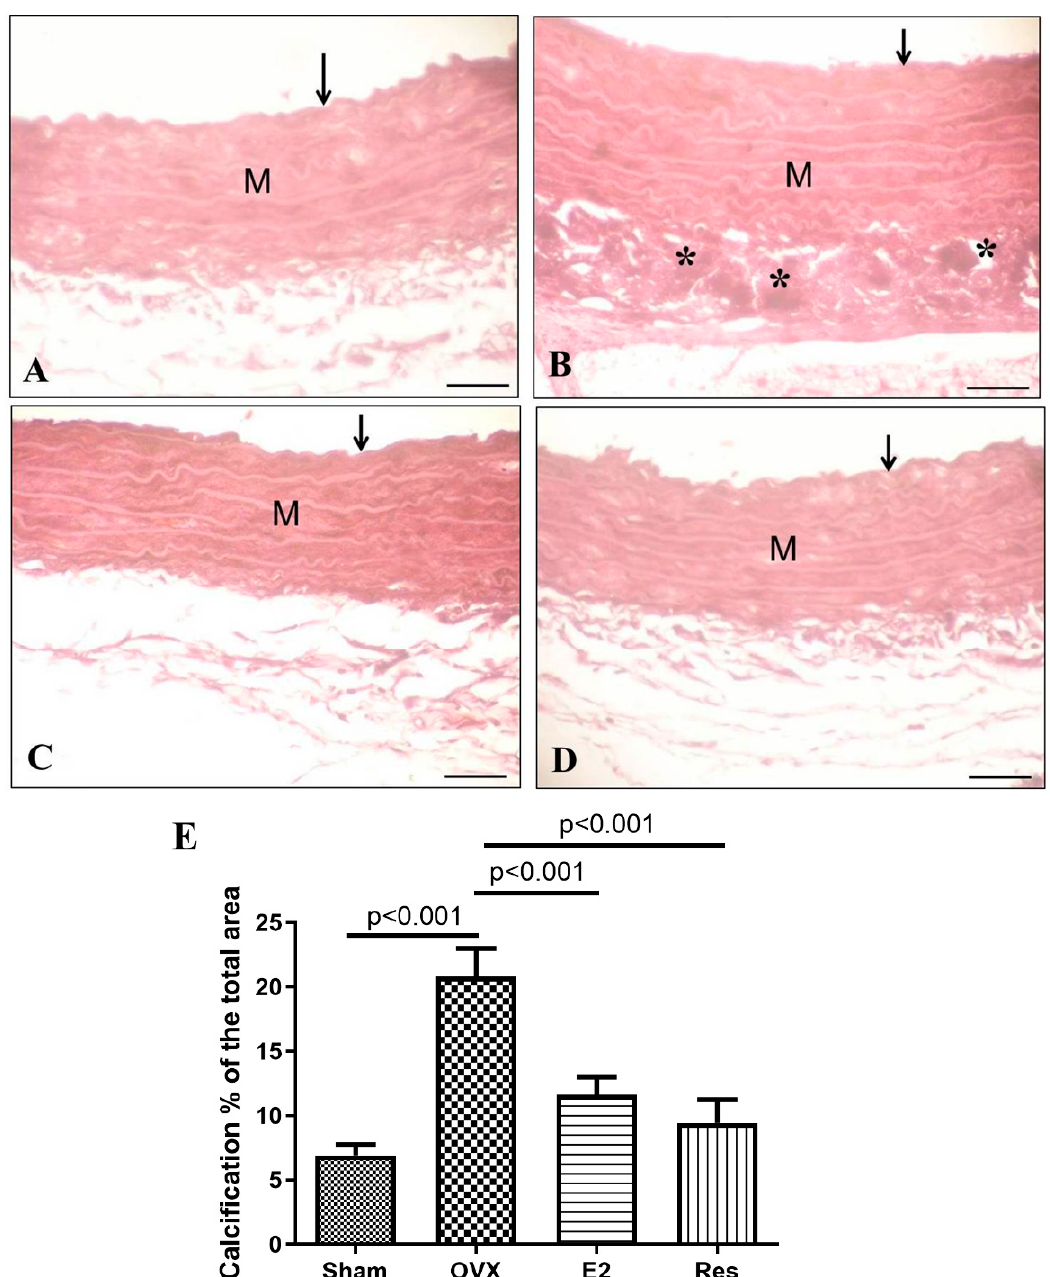
Figure 6. Resveratrol and estradiol ameliorated aortic calcification in ovariectomized rats, as shown by Alizarin red-stained sections. ( A ) The sham group showing tunica intima (arrow) and tunica media (M). ( B ) OVX rats showing marked calcium deposition (*) in the tunica media (M). ( C ) Estradiol-treated rats. ( D ) Resveratrol-treated rats. ( E ) Aortic calcification percentage. Graph shows mean ± SD. Scale bar 20 µ m. OVX: ovariectomized rats; E2: estradiol; Res: resveratrol.